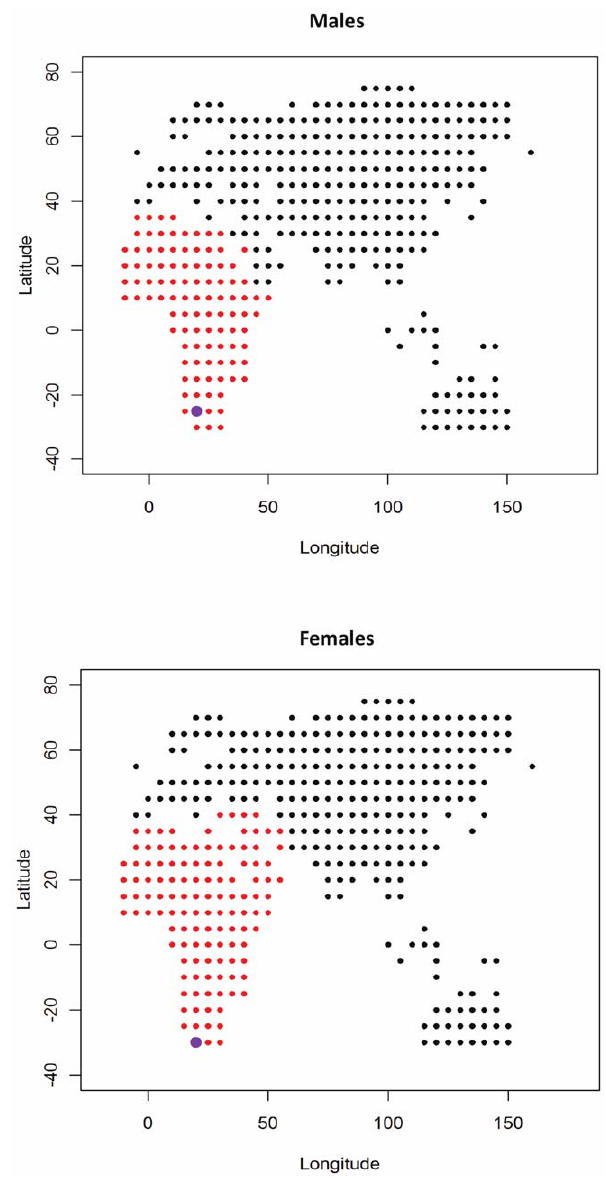
Figure 4. Points of origin of human expansion tested in males (above) and females (below). The origin that returned the highest correlation between phenotypic variance and geographic distance is highlighted with a larger dot. The origins that gave a regression model within 4 points of delta AIC from the best origin are highlighted by red dots. Americas not shown but included in analysis. coefficient of the OoA model. Therefore, the results reported in Table 5 should be considered as minimal values. One possible reason for the difference highlighted between this study and analogous tests of the OoA pattern on the pelvis and the cranium could be the nature of the data themselves. All previous studies made use of linear measurement data collected using caliper-based traditional morphometric methods. Repeating the analyses on inter-landmark distances, however, returned very similar results (r 2 = 0.32–0.37), again supporting a very strong OoA pattern in the pelvis. It appears, therefore, that indepen- dently of the specific category of data, global shape variation of the